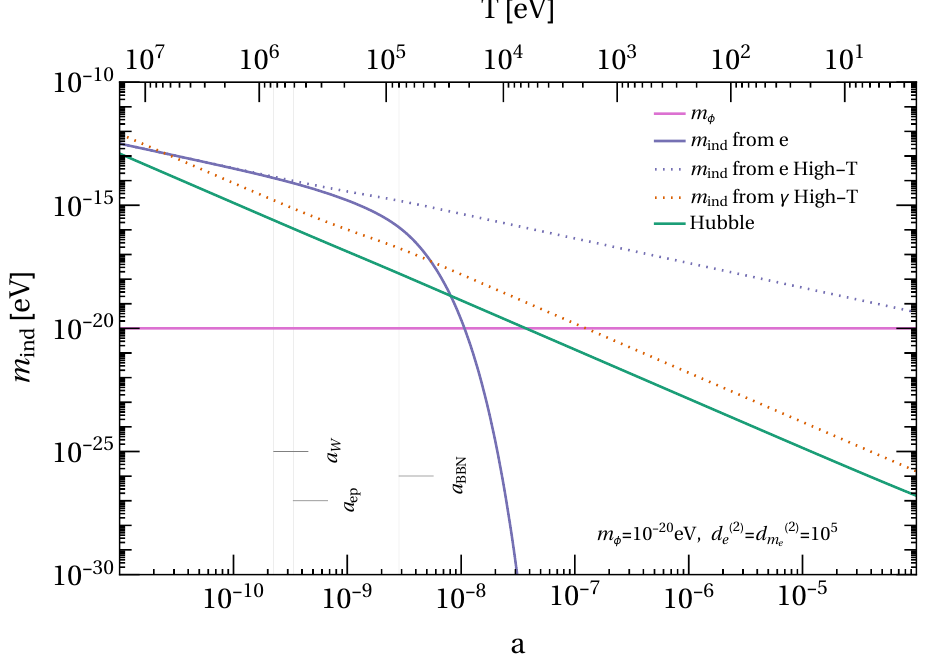
Figure 2 . Potential contributions to m eff from the electron and photon coupling for the couplings = 10 5 . The dotted lines are the high-temperature approximations for the electron d (2) e = 10 5 or d (2) m e and photon couplings,